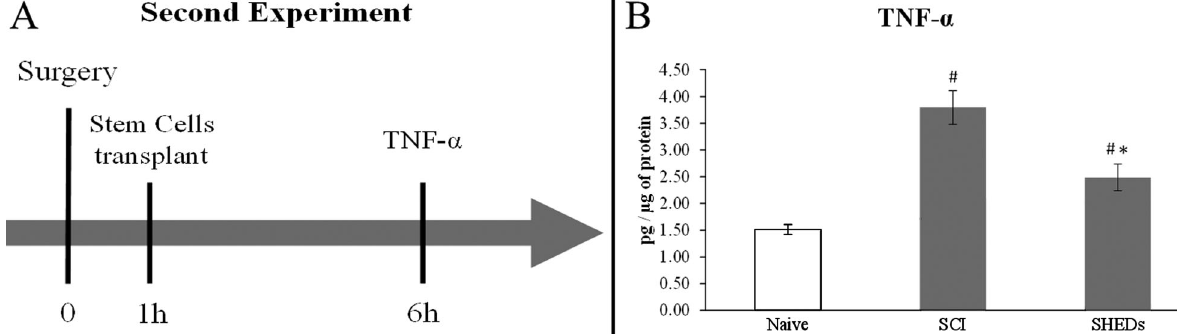
Figure 2. Design of the second experiment ( A ). ELISA results for TNF- a ( B ). Naive: rats with no manipulation; SCI: rats with laminectomy followed by spinal cord injury; and SHEDs: rats with SCI treated with stem cells from human exfoliated deciduous teeth (SHEDs). Data reported as means ± SE. # P o 0.05, compared to Naive group; *P o 0.05, compared to SCI group (one-way ANOVA followed by Tukey ’ s post hoc